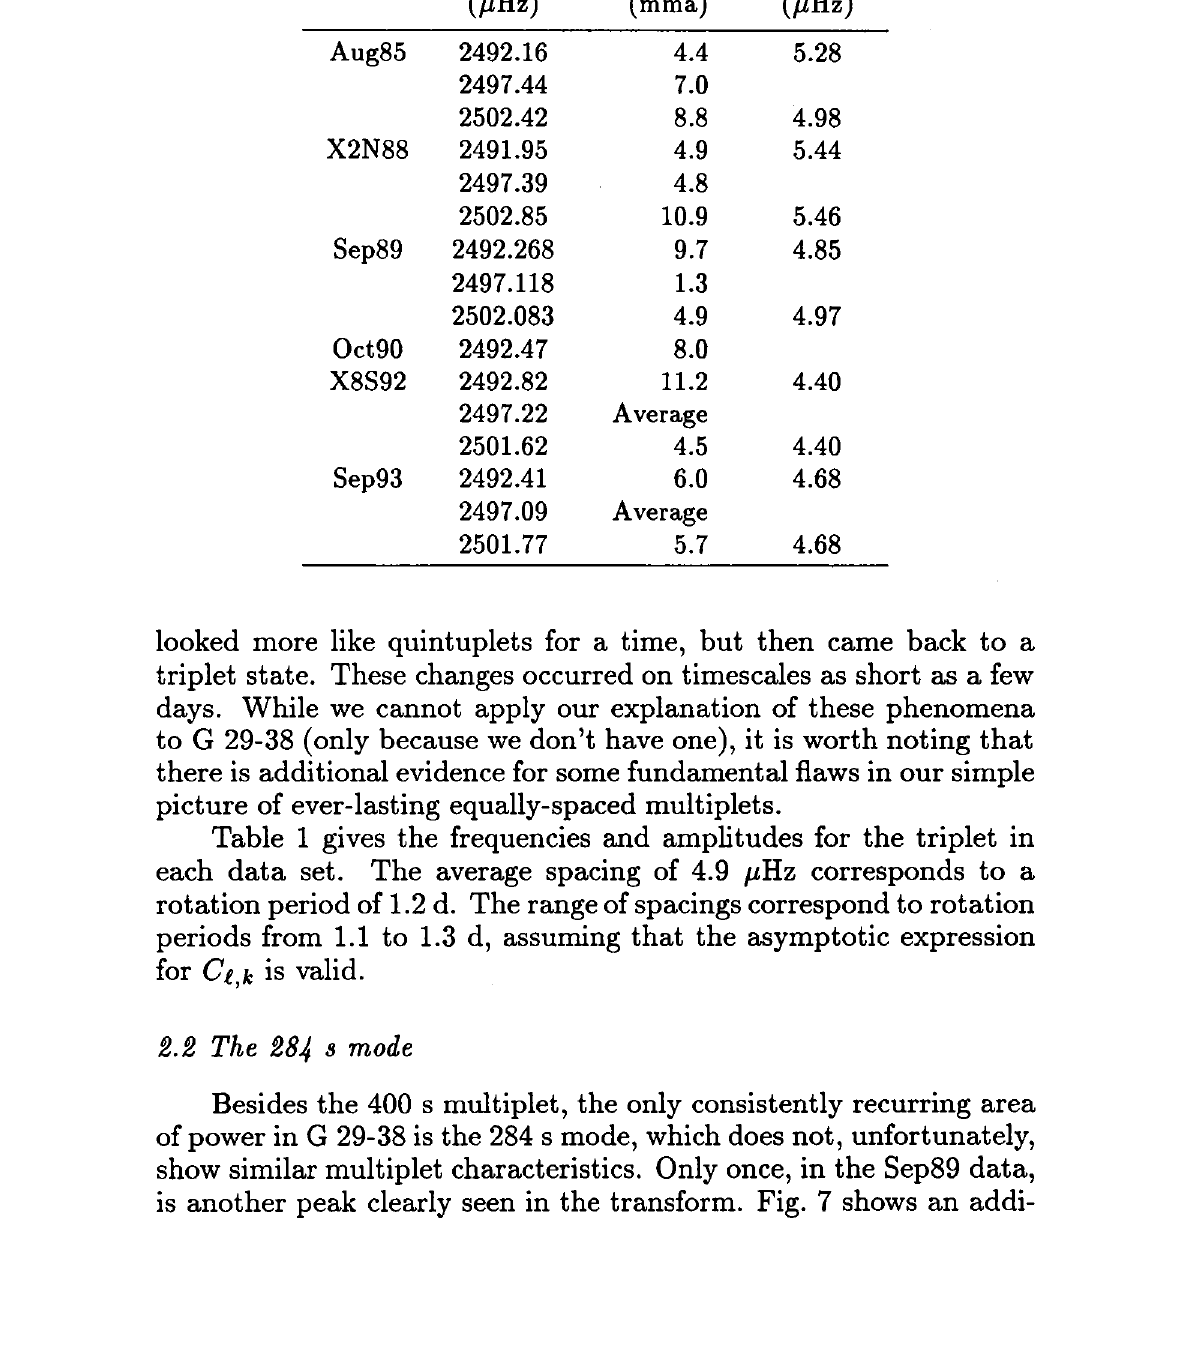
Table 1. G 29-38's 400 s triplet over time Frequency Amplitude Data set (//Hz) (mma)